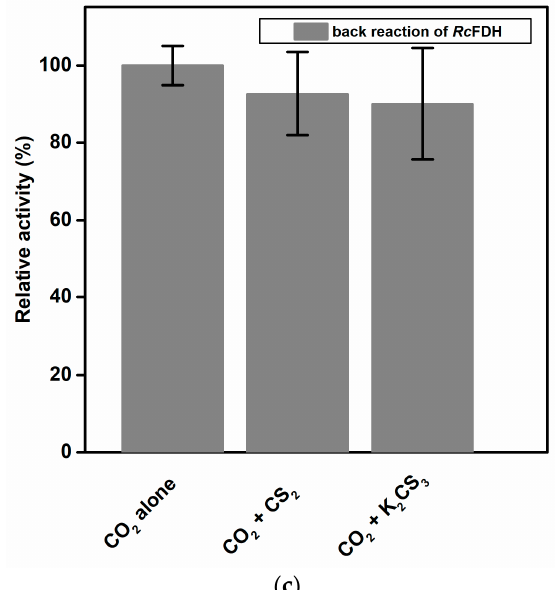
Figure 7. ( a ) CO 2 reduction reaction of Rc FDH in the presence of H 218 O. Reaction mixture of 100 µL contained 2mM reduced methyl viologen and CO 2 -purged phosphate buffer (100 mM, pH 6.6). The reaction was started by adding the Rc FDH (5 µM) and H 218 O (50%) mixture into the solution anaerobically at 25 °C. The negative control had no H 218 O added to it and in the case of the positive control, H 218 O and CO 2 were mixed 30 min prior to Rc FDH addition. Reactions were stopped after 10 s by adding 30 µL of acetone followed by freezing in liquid nitrogen. Samples were derivatized and analyzed by GC − MS, as detailed in the Methods section. ( b ) The CO 2 reduction reaction of Rc FDH using CO 2 and/or NaHC 13 O 3 as substrates. The reaction volume of 100 µL contained 2mM reduced methyl viologen and a CO 2 saturated phosphate buffer (100 mM, pH 6.6) with different concentrations of NaHC 13 O 3 solution. The reaction was started by adding Rc FDH (5µM) anaerobically at 25 °C. Reactions were stopped after 10 s by adding 30 µL of acetone followed by freezing in liquid nitrogen. Samples were derivatized and analyzed by using GC − MS. Black bars represent the ratios of normal and 13 C-labeled formate produced. Blue bars represent the headspace CO 2 / 13 CO 2 ratios analyzed by GC − MS before the addition of Rc FDH. ( c ) The effect of CS2 and K 2 CS 3 on the back reaction of Rc FDH. A reaction volume of 100 µL contained 1mM NAD + and a CO 2 -saturated phosphate buffer (100 mM, pH 6.6). A total of 150 mM of carbon disulfide (CS 2 ) and 5 mM of potassium trithiocarbonate were added to check inhibition. The reaction was monitored at 340 nm for 1 min after adding Rc FDH (5 µM) anaerobically at 25 °C.